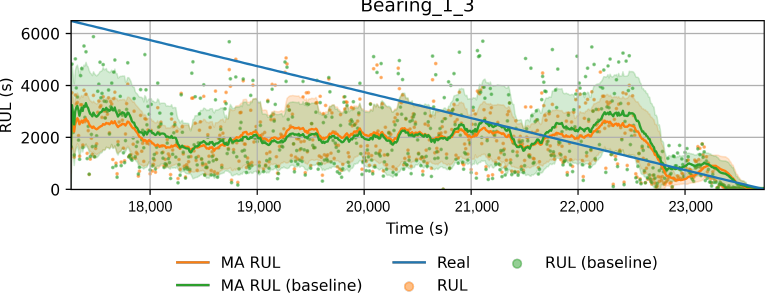
Figure 17. RUL estimation for bearing 1_3. Comparing the benchmark (green) and the proposed method. Intervals as the +/ − 1 running standard deviation.